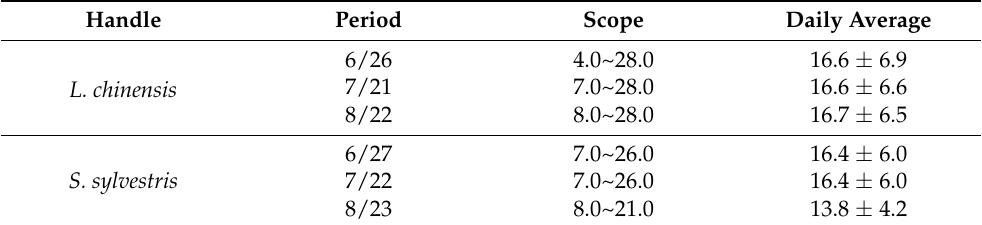
Table 1. Day and night concentrations of total gaseous mercury (ng · m − 3 ). Handle Period Scope Daily